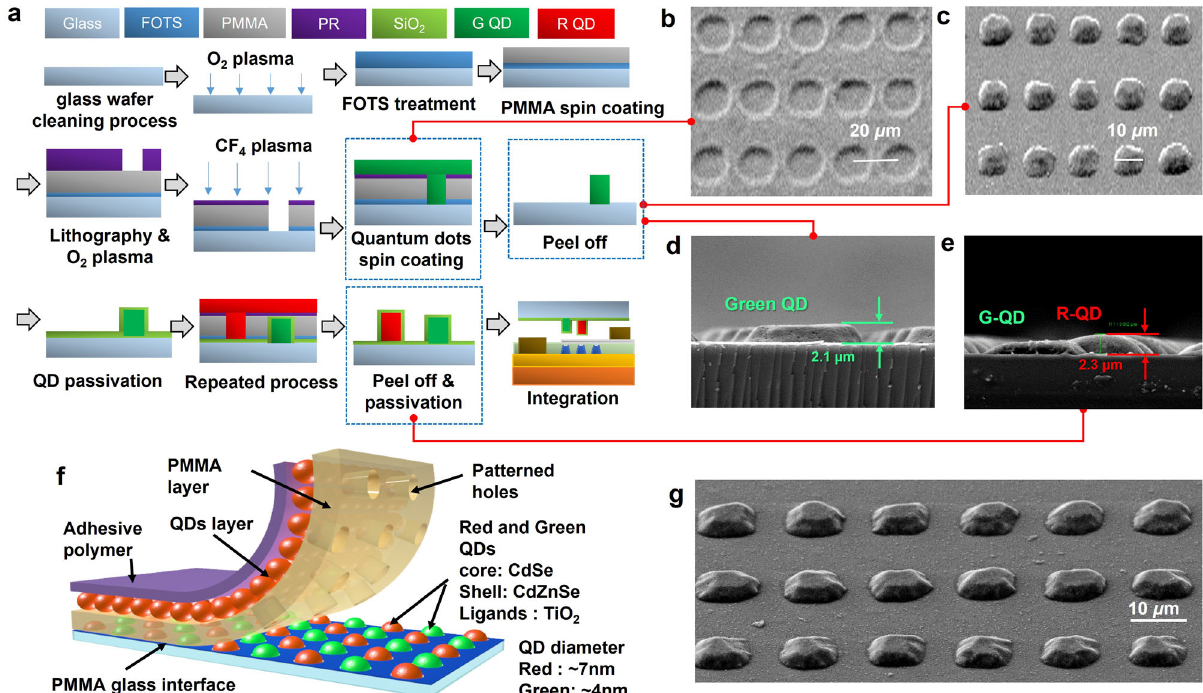
Fig. 3 Patterning of QD fi lms using the elastomer-assisted dry-patterning process. a A schematic of the overall process of dry patterning of microscale QD pixels. b QD layer before the peel-off process. c Patterned individual QD pixels. d SEM image of a QD array with a single - color QD pattern. e SEM image of a QD array with both QDs sequentially patterned. f Illustration of the elastomeric mask used for QD dry patterning. g Isotropic SEM image of the patterned